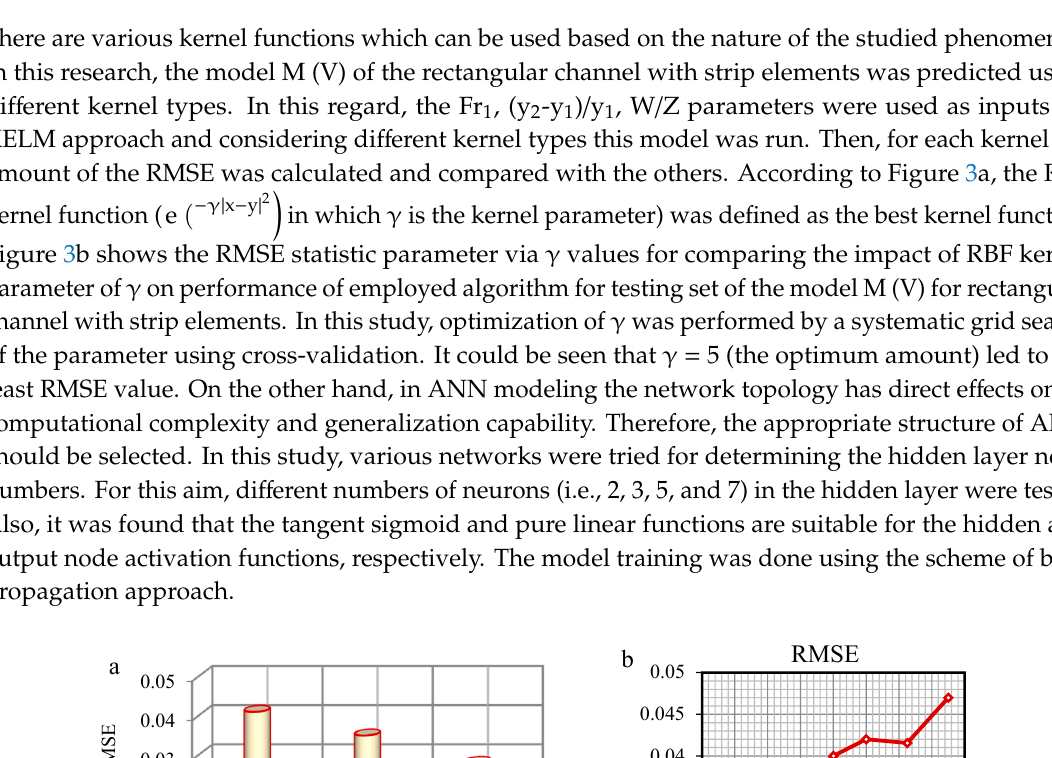
Table 3. Statistical parameters of the KELM models for the rectangular shape channels.